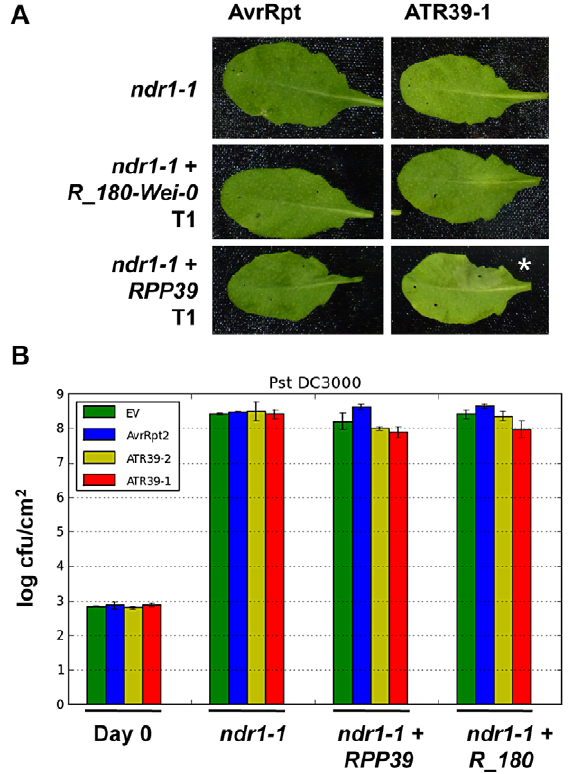
Figure 7. NDR1 is required for full resistance but dispensable for HR mediated by RPP39. A) Pf 0 inoculation of T1 transgenic Arabidopsis ndr1 mutant plants transformed with the indicated R genes. The lower half of each leaf was inoculated with an empty vector control. Pictures were taken 24 hpi. Stars highlight positive HR. B) Pst DC3000 growth assay on select T2 transgenic ndr1 plants transformed with the indicated R gene candidates. Statistical analysis using Student’s t-test identified no significant differences. Experiments were repeated at least twice with similar results.